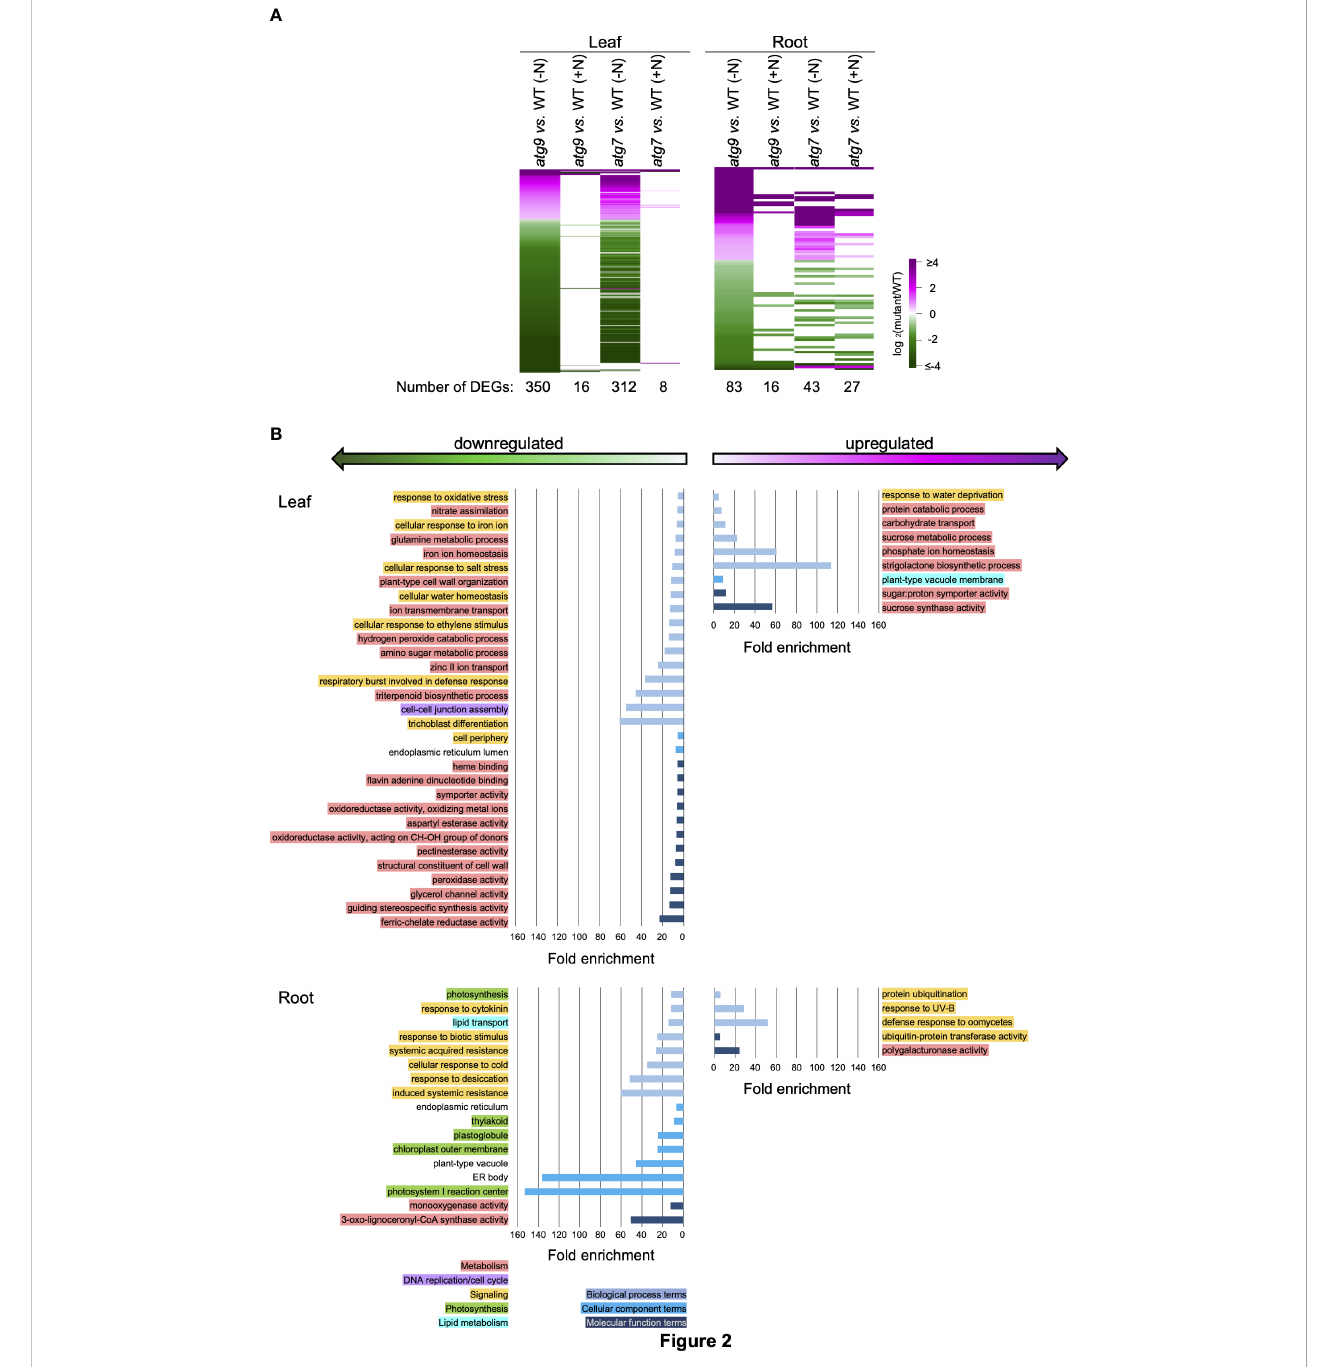
FIGURE 2 Biological functionalities identi fi ed by DEGs induced by the atg9 mutation in leaves and roots. (A) . Heat map visualization of the relative expression of 350 and 83 DEGs identi fi ed by comparing transcript abundances in leaves and roots of the atg9 mutant versus WT grown in (-N) condition. The expression of each of these DEGs is compared to their relative expression levels in the other indicated comparisons. The color scale indicates the relative expression level of each DEG in each comparison. (B) . Using the list of upregulated and downregulated DEGs for leaves and roots, GO terms that show >5-fold enrichment were generated by the sequential use of DAVID and REVIGO. The GO terms that are unique to the altered transcriptome of the leaves and roots are presented. GO enrichment terms that are shared between the leaves and roots are presented in Supplemental Figure 2. The graphs plot the fold-enrichment for each GO enrichment terms associated with Biological Processes ( ■ ), Cellular Component ( ■ ) and Molecular Function ( ■ ). Each GO enrichment term is categorized with higher level functionalities associated with metabolism ( ■ ), DNA replication ( ■ ), signaling ( ■ ), photosynthesis ( ■ ) and lipid metabolism ( ■